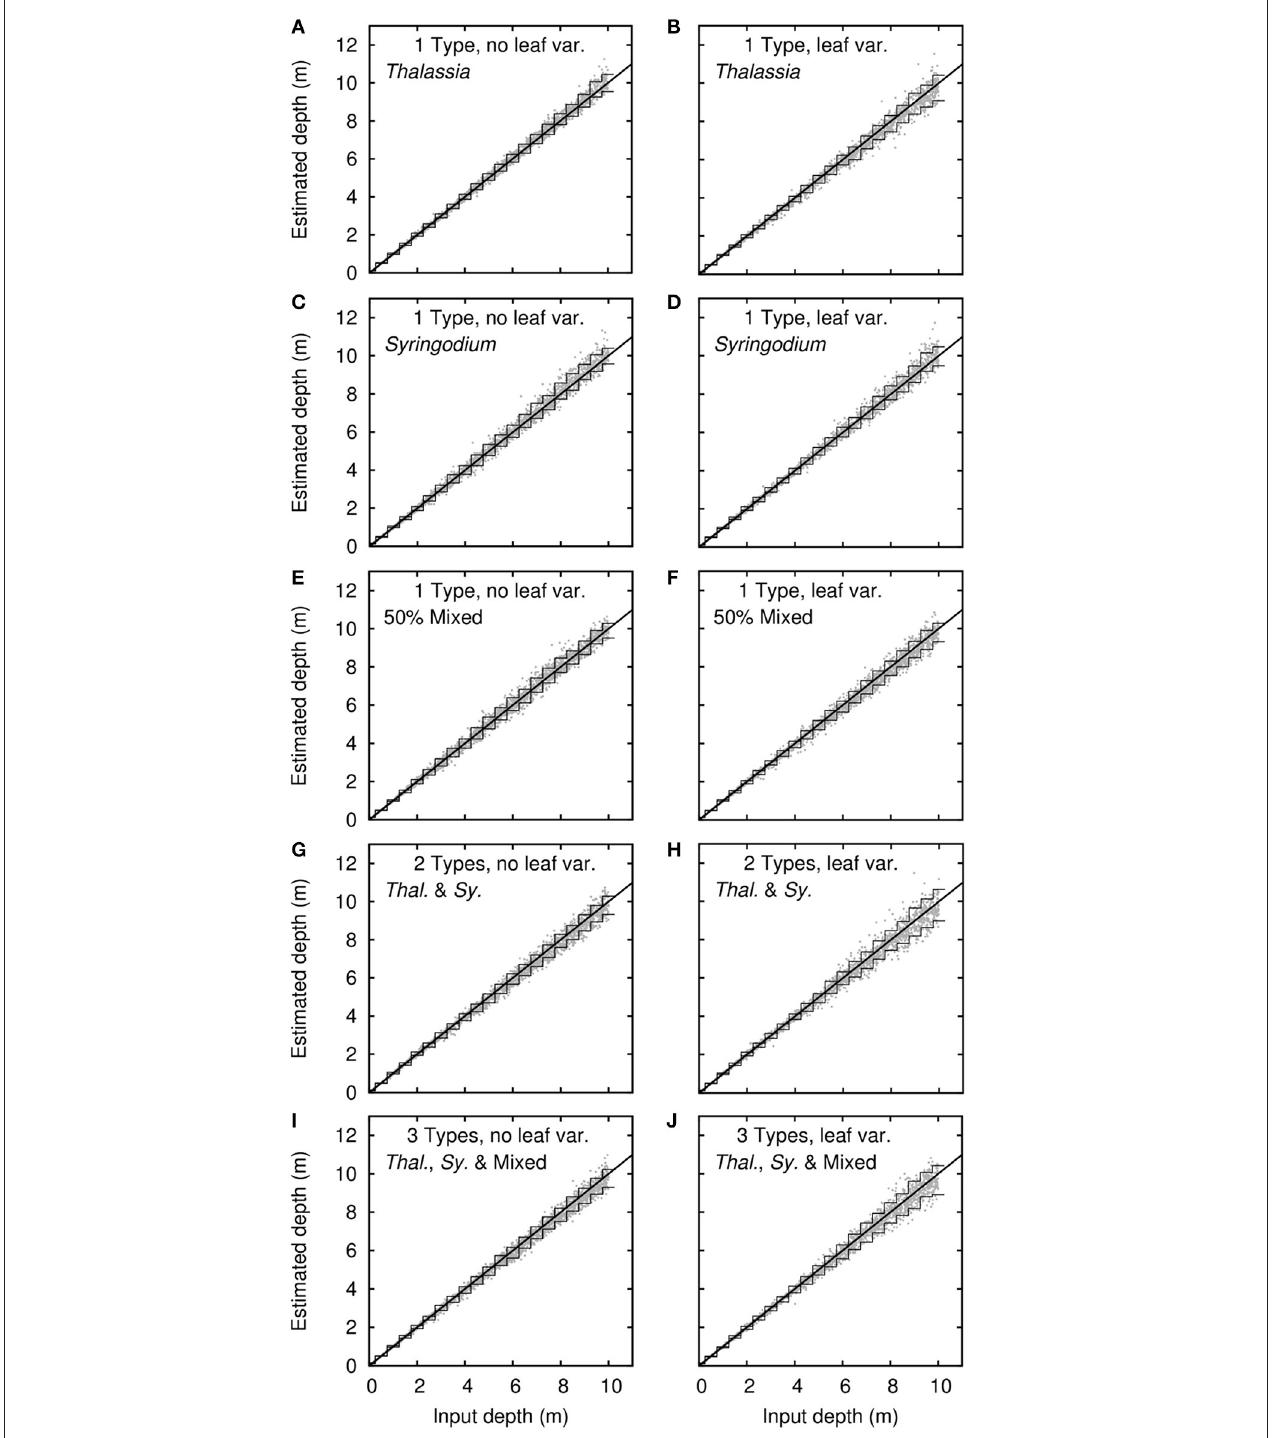
FIGURE 7 | Sensitivity analysis results for bathymetry. Dots are 2,500 noise-perturbed self-inversion results, lines are mean 90% confidence intervals binned in steps of 0.5m. Treatments are (A–F) single benthic types of Thalassia , Syringodium and 50% mixed canopies, plus (G–J) models with multiple bottom types. Right and left columns are with and without variation in leaf